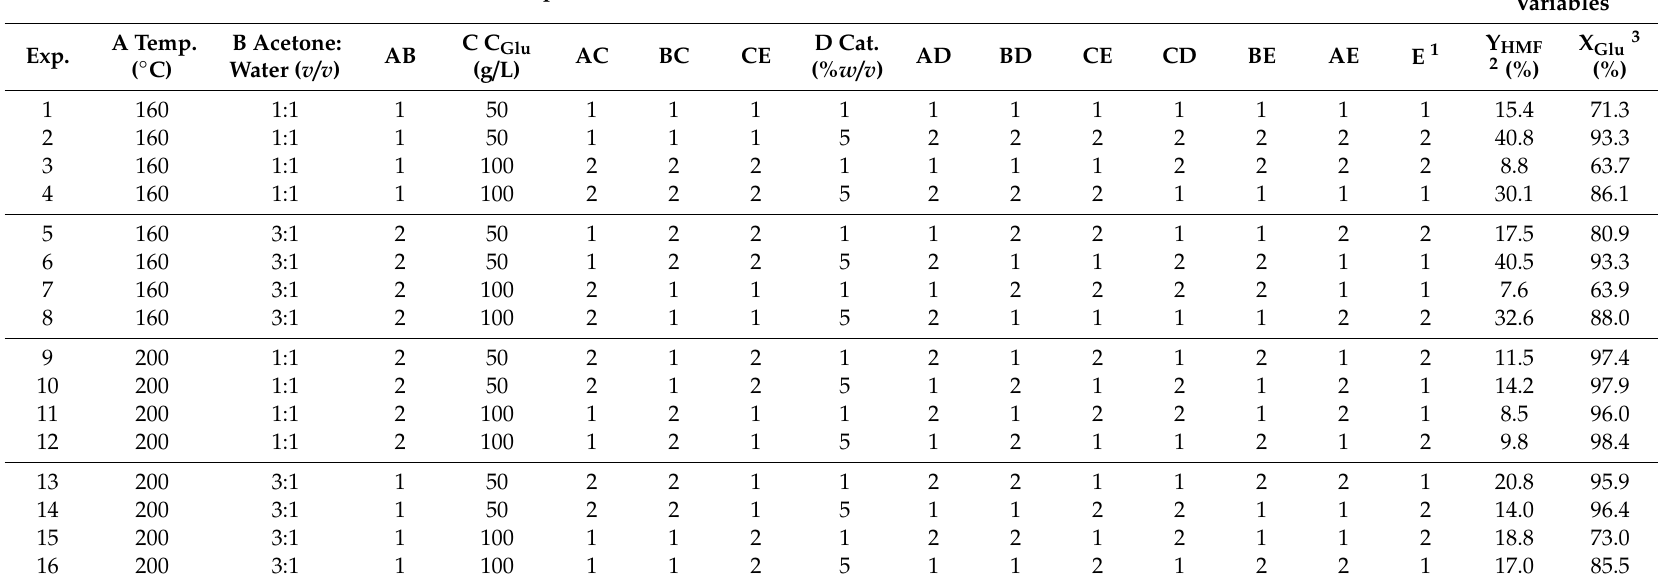
Table 4. Taguchi’s L 16 orthogonal array to evaluate the e ff ect of temperature, acetone-to-water ratio, glucose concentration, and catalyst concentration on 5-Hydroxymethylfurfural production from glucose. Experimental Conditions (Factors and Interactions)